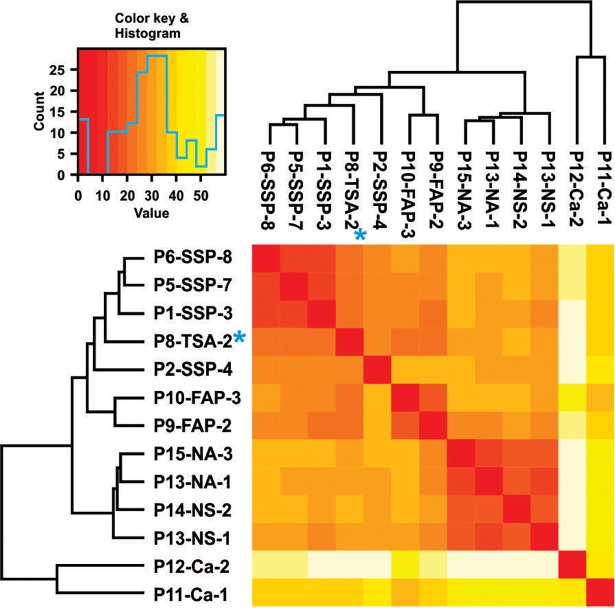
Gene expression profiling of colon samples.Hierarchical clustering and sample-to-sample distance heatmap of the expression of protein coding genes. SSP samples are clustered together, FAP samples also clustered together. Gene expression in TSA-2 that has both APC and BRAF mutation is more similar to the pattern of SSP expression cluster. The gene expression pattern of FAP show about 50% similarity to the gene expression of SSP, although the DNA methylation patterns of these two polyp types differ significantly. Therefore studying the DNA methylation marker can lead to detect SSP more specifically than studying the gene expression.